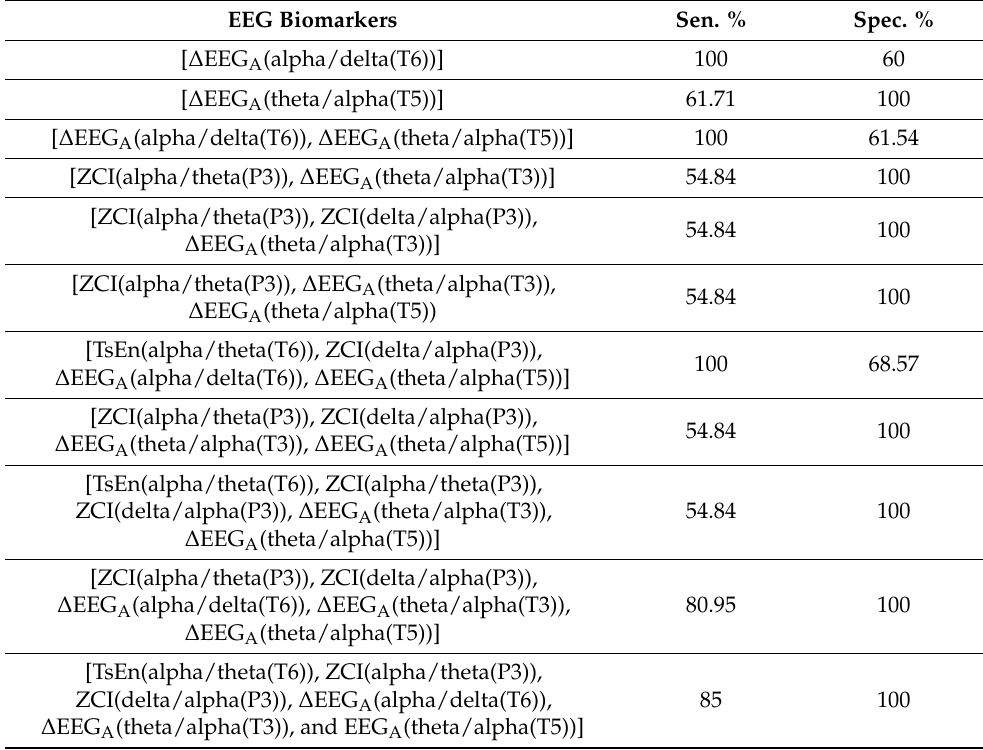
Table 11. Performance of biomarker panels consisting of one, two, three, four, five, and six biomarkers for dataset B. EEG Biomarkers Sen. % Spec.